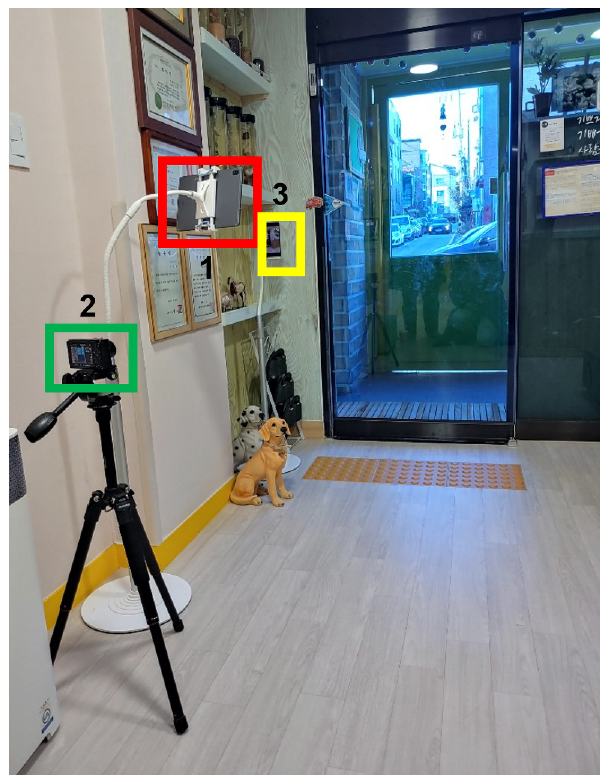
Figure 16. Installation of the camera indoors